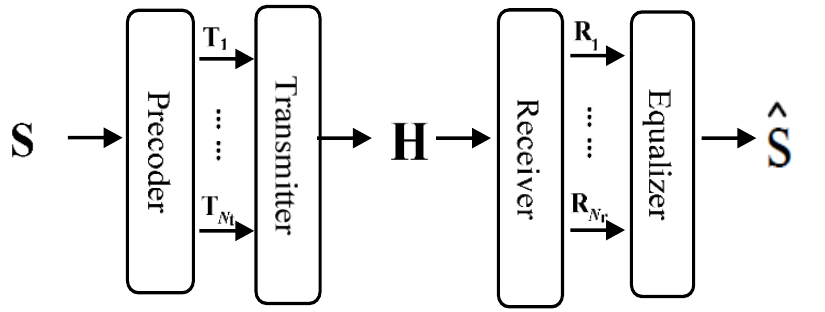
Figure 1. Diagram of MIMO VLC system.